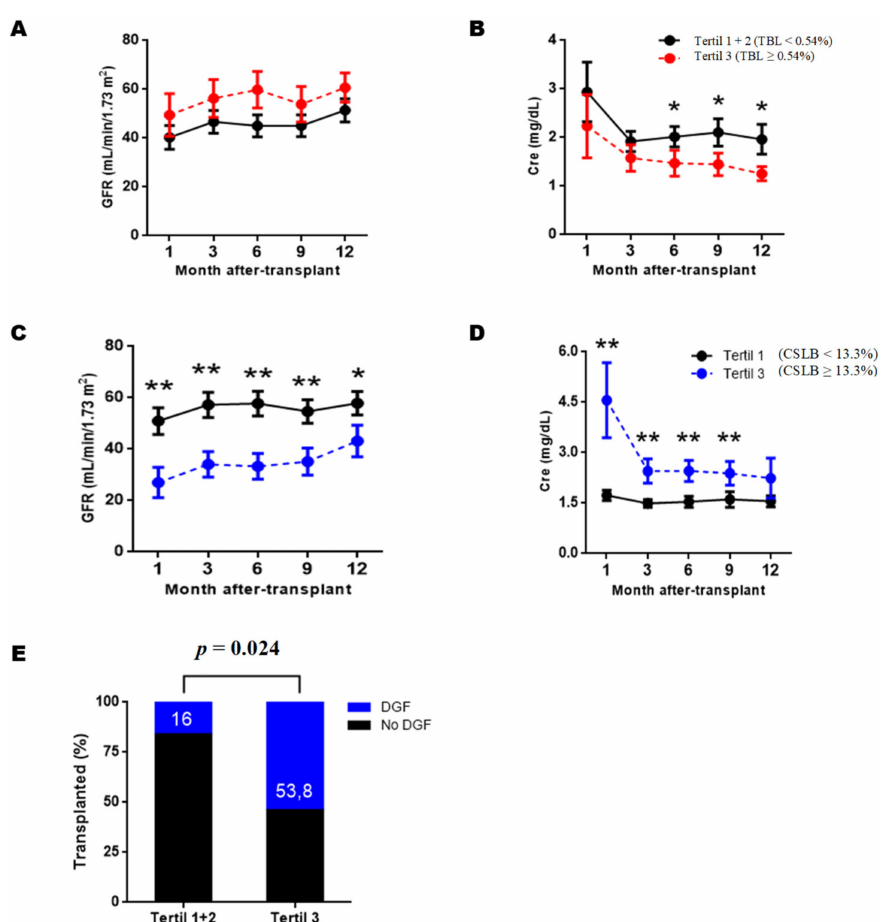
Figure 2. Estimated glomerular filtration and serum creatinine levels of RTRs according to the transitional and Class-Switched B lymphocyte levels at 12 months post-transplantation. Renal recipients were grouped into tertiles based on transitional B lymphocytes’ relative frequencies (TBL) and Class-Switched (BLCS). At each post-transplant time, the estimated glomerular filtration rate (GFR) ( A , C ) and serum creatinine (Cre) ( B , D ) of the two groups were compared using the U-Mann– Whitney test. Fisher’s exact test ( E ) was used to compare delayed graft function incidence (DGF). Values are represented as the mean ± SEM. Values of p < 0.05 were considered statistically significant. * p < 0.05. ** p <